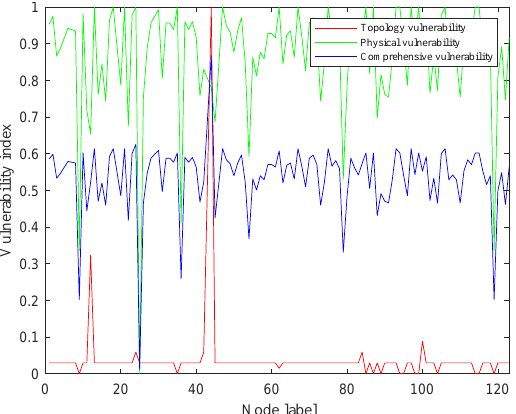
Figure 11. Vulnerability assessment of small world network. Table 6. Vulnerability Indexes of Top 20 nodes.